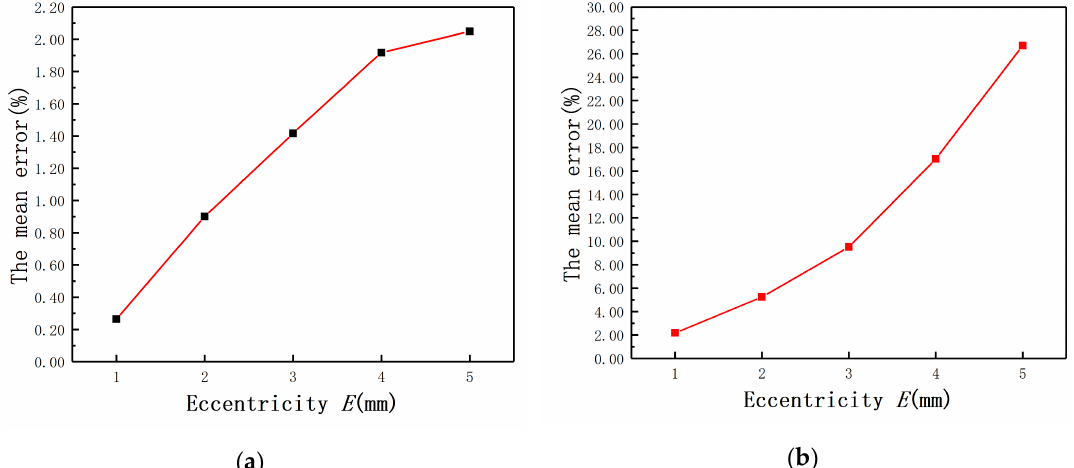
Figure 10. The mean errors with di ff erent eccentricities: ( a ) L s ; ( b ) R s .